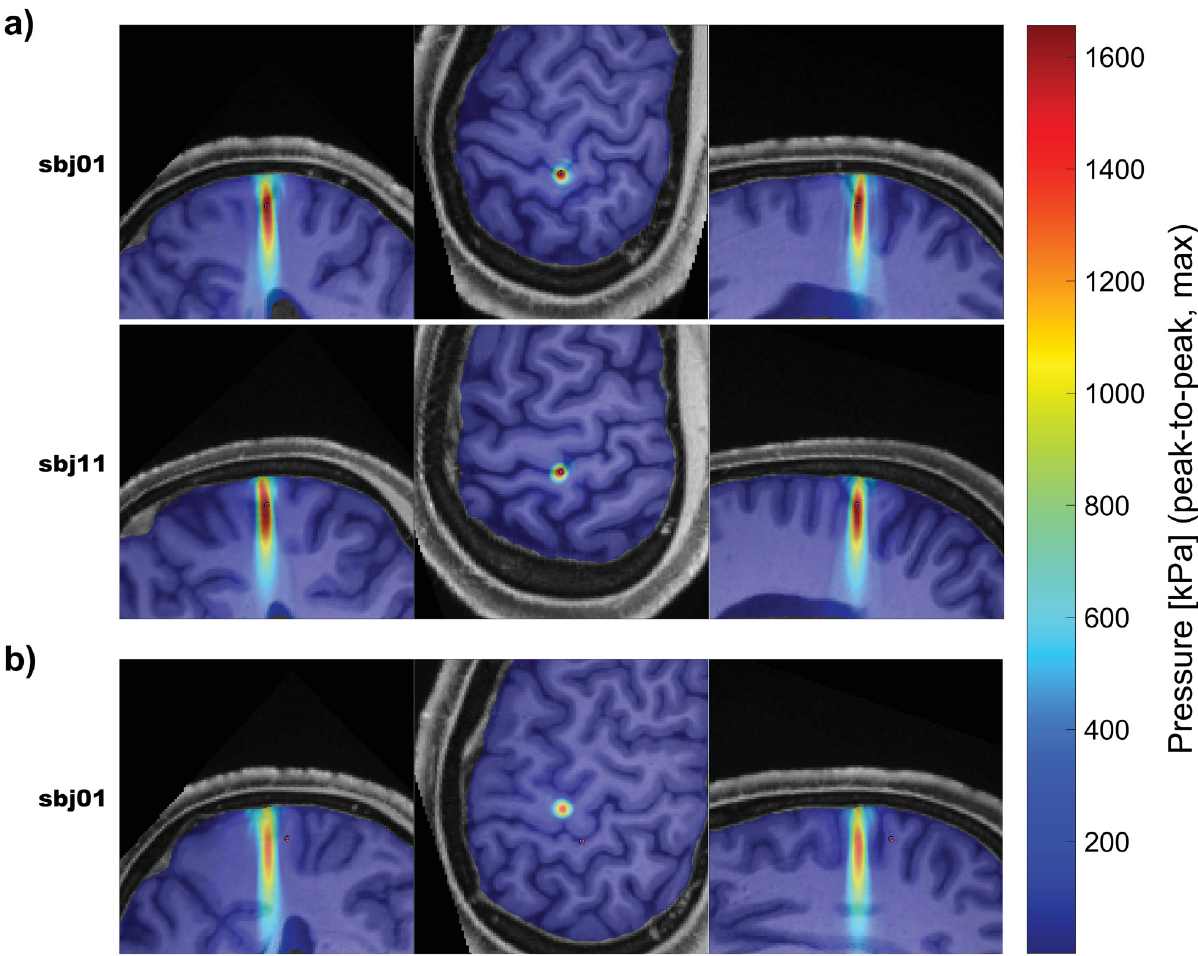
Fig 7. Simulated pressures (examples). Examples of simulated pressures for targets used in the experiment. These three examples were chosen to highlight how a small spatial deviation can significantly affect sonication exposure at a given coordinate. Simulated pressure maps are overlayed over the respective structural MRI. One example per row; all three dimensions per row. Slices shown were made at the maximum pressure value. Note that these are not standard slices (i.e. coronal, sagittal, horizontal), since the volume was reoriented as part of pre-simulation processing, A small magenta circle denotes the registered M1 coordinate. (a) Two example trajectories that were aimed at the respective subject’s M1 hand . (b) One example trajectory that was not aimed at the respective subject’s M1 hand . Pressure maps for all subjects and trajectories are available in the (S14